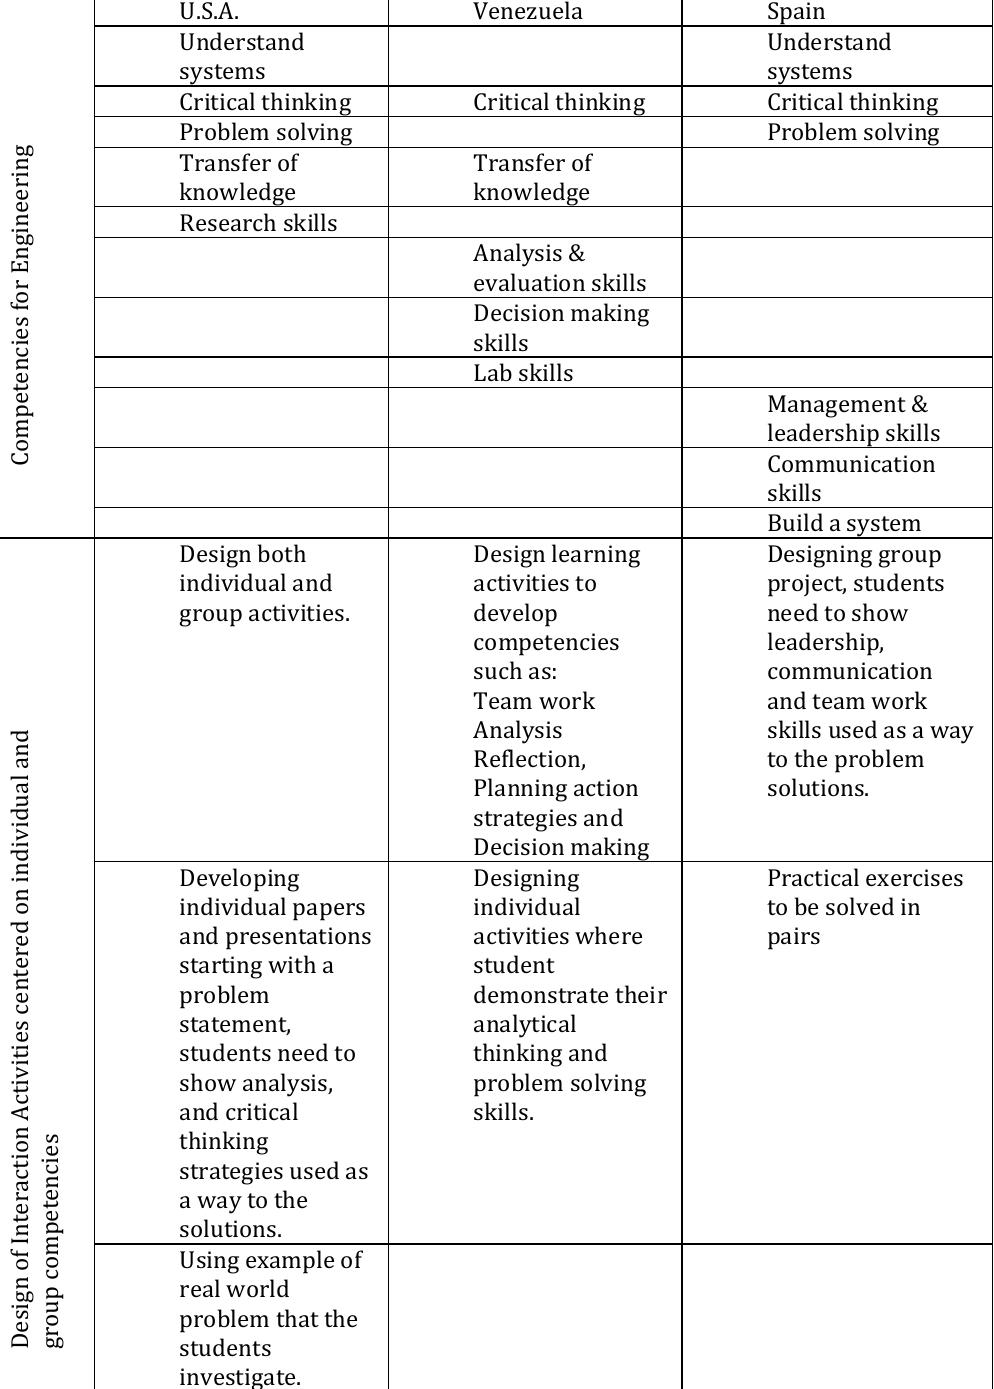
Competencies and Design of Interaction for Engineering Across Three